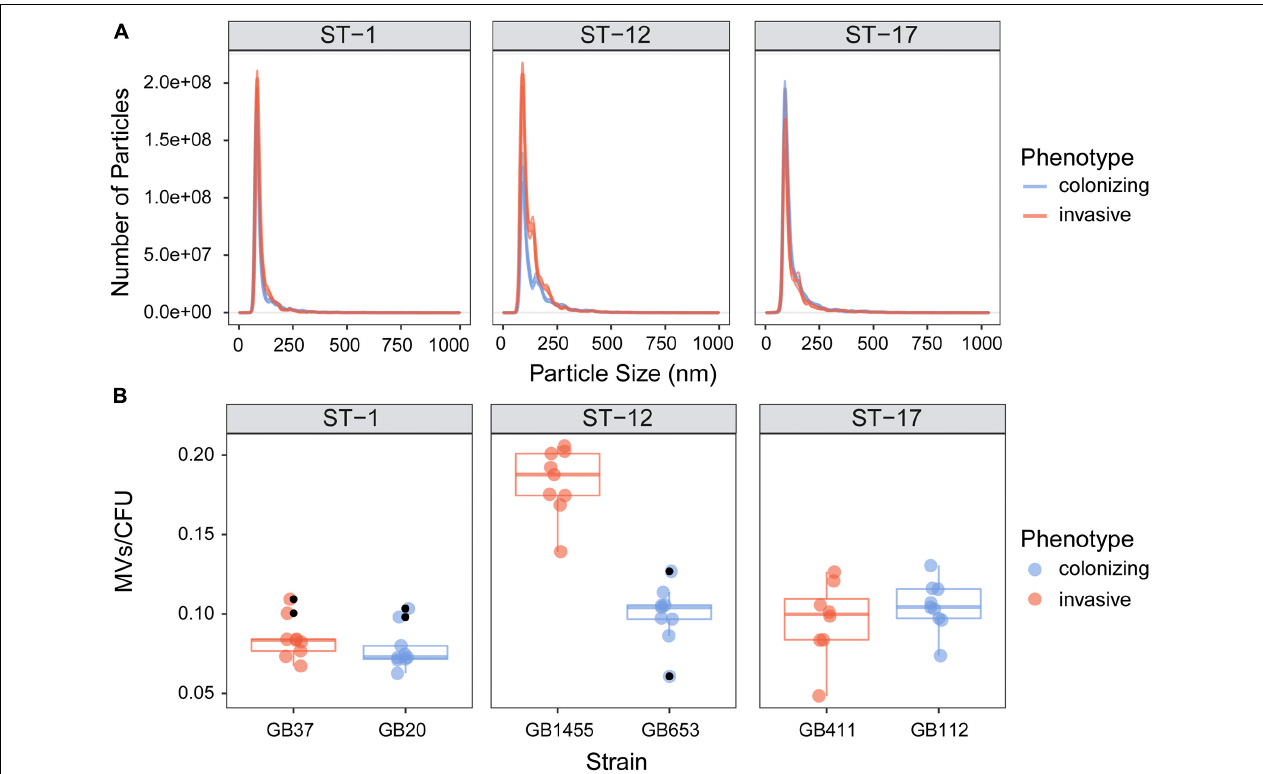
FIGURE 3 | Quantitative assessment of membrane vesicle (MV) production across strains. MVs were isolated by differential centrifugation and quantified using NanoSight analysis. The vesicle (A) size distribution and (B) number per bacterial colony forming units (CFUs) are shown for the invasive and colonizing strains by sequence type (ST). For panel A, the lines represent the mean, while the shading surrounding the mean is the standard error of the mean. For panel B, total MV counts were normalized to the number of CFUs in the original bacterial cultures. The horizontal lines within each box show the median across 8–9 biological replicates (indicated by colored dots). The black dots represent outliers identified by multiplying the interquartile range by 1.5, which was used to extend the upper and lower quartiles. Outliers were observed for three of the six strains and were excluded prior to statistical analysis. GB1455 produced significantly more MVs than all other strains ( p < 0.05) and GB20 produced significantly fewer MVs relative to all other strains ( p < 0.05) except